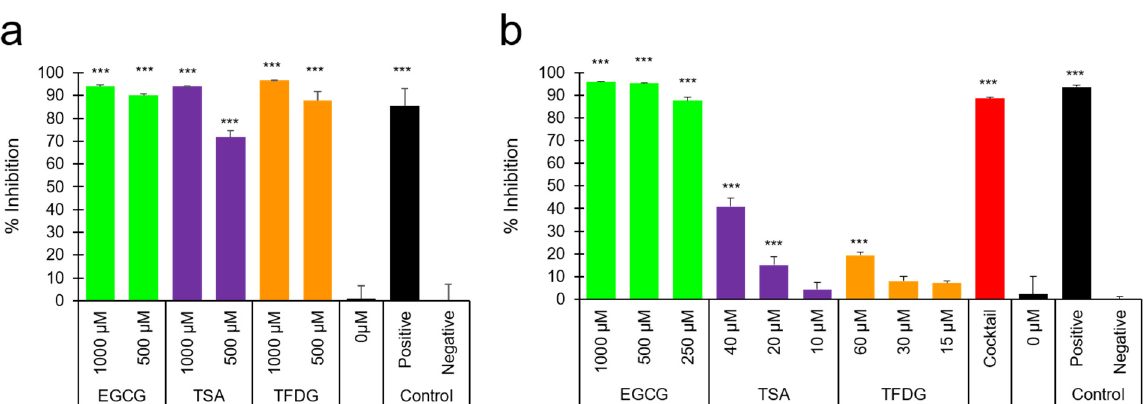
Figure 6. EGCG, TSA, and TFDG interfered with the interaction between ACE2 and RBD. The indicated concentrations of each compound as well as a mixture of 40 µM TSA, 75 µM TF3G, 35 µM TF3 ′ G, and 60 µM TFDG (cocktail) were subjected to a neutralizing assay using a SARS-CoV-2 Surrogate Virus Neutralization Test Kit (GenScript, Piscataway, NJ, USA) as described in the Materials and Methods section. % Inhibition for each sample is shown. Values are means ± S.D. ( n = 3 ( a ) or 4 ( b )). *** p < 0.001 vs. Negative control by Tukey’s multiple comparison test.